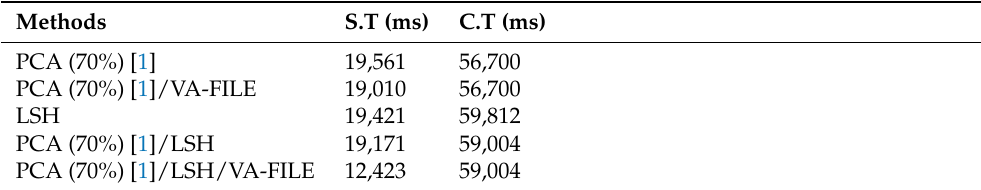
Table 2. Computation and the search time within ImageNet database.